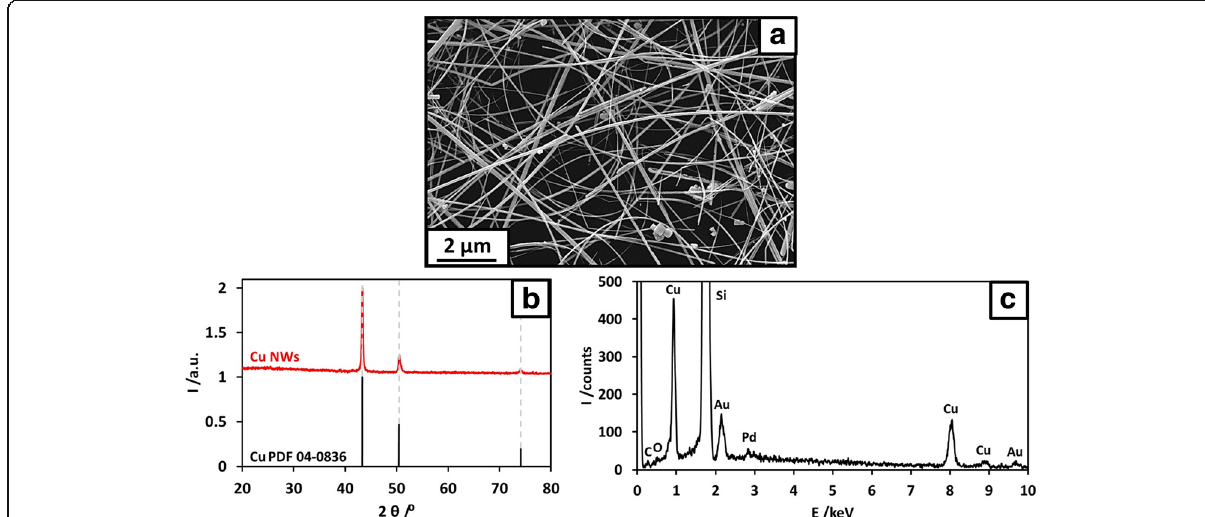
and a few cubic Cu NPs. b XRD pattern. c EDS spectrum showing the high purity of the washed Cu NWs